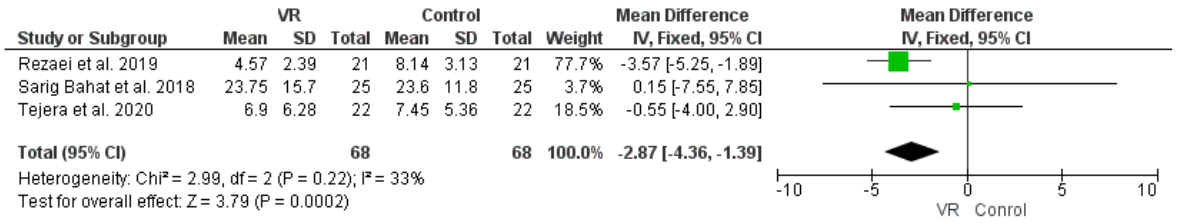
Figure 8. Effect of VR and control intervention on measure of ODI outcome. Green squares represent